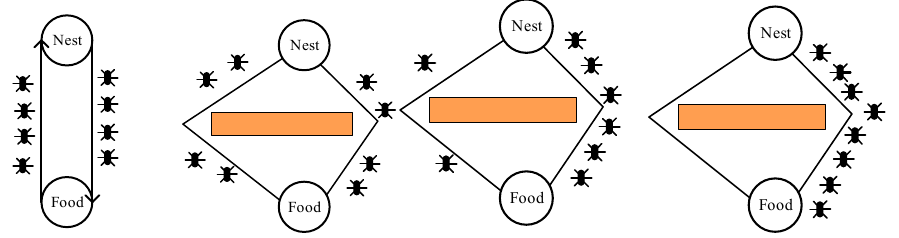
Figure 1. Schematic diagram of ant colony optimization (ACO).